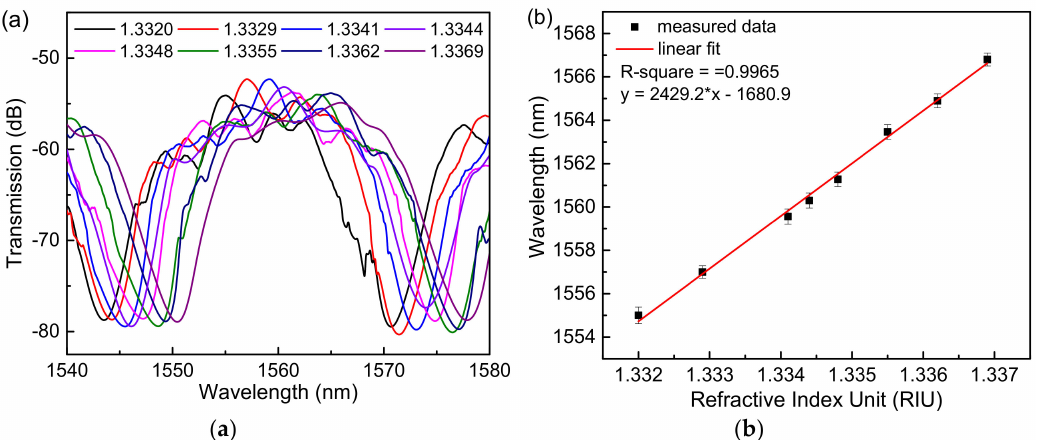
Figure 4. The experiment of the sensor based on a cascaded Sagnac-interferometer loop with the Hi-Bi microfiber to measure analyte RI. ( a ) The transmission spectra in different RI solutions. ( b ) Linear fitting